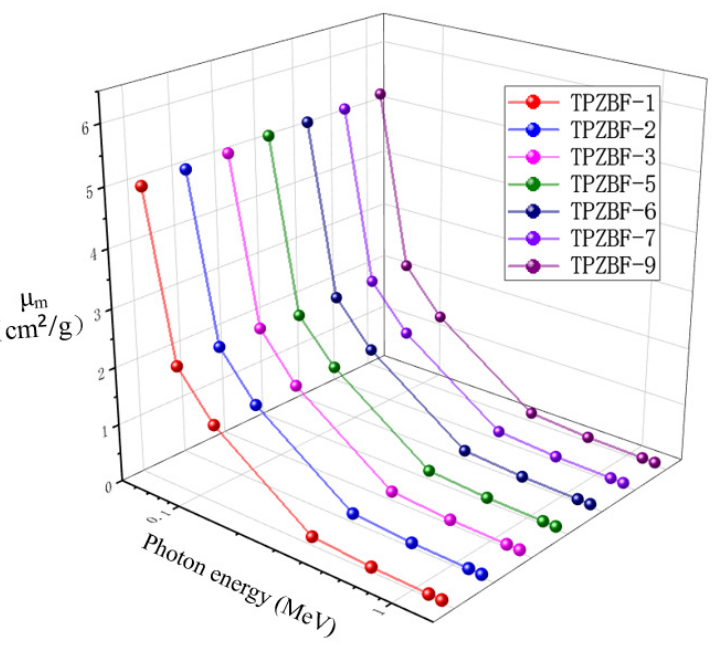
Figure 4. Comparison of mass attenuation coefficient obtained from experiment and XCOM simula- tion calculation.